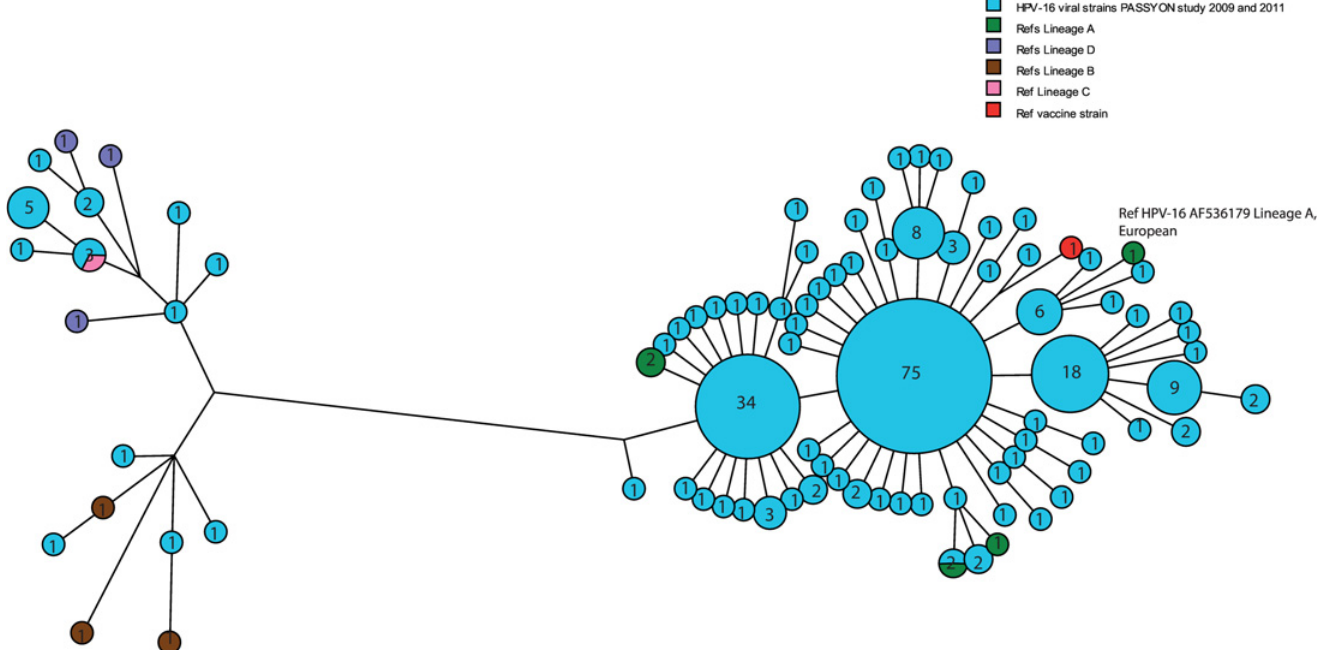
Fig 1. Maximum parsimony tree based on nucleotide sequences of L1 HPV-16 gene. Study sequences of 241 HPV-16 positive samples collected in 2009 and 2011 are shown in blue. Reference sequences of European/A lineages (GenBank reference AF536179 K02718 = NC001526,